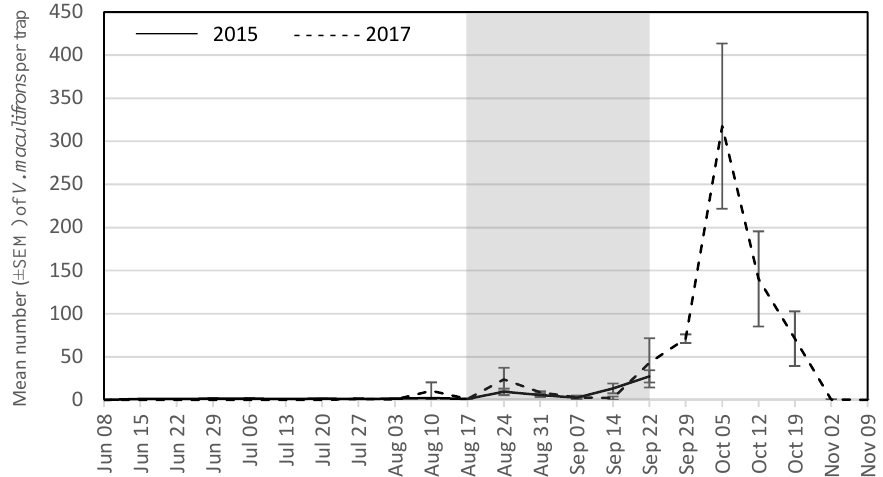
Figure 1. Mean number ( ± SEM) of Vespula maculifrons caught per trap per week in South Central Wisconsin vineyards in traps baited with acetic acid and isobutanol (AAIB) from 8 June to 22 September 2015 (solid line) and from 8 June to 9 November 2017 (dashed line). The shaded region indicates the overall grape harvest for all grape cultivars present across all vineyards sampled.